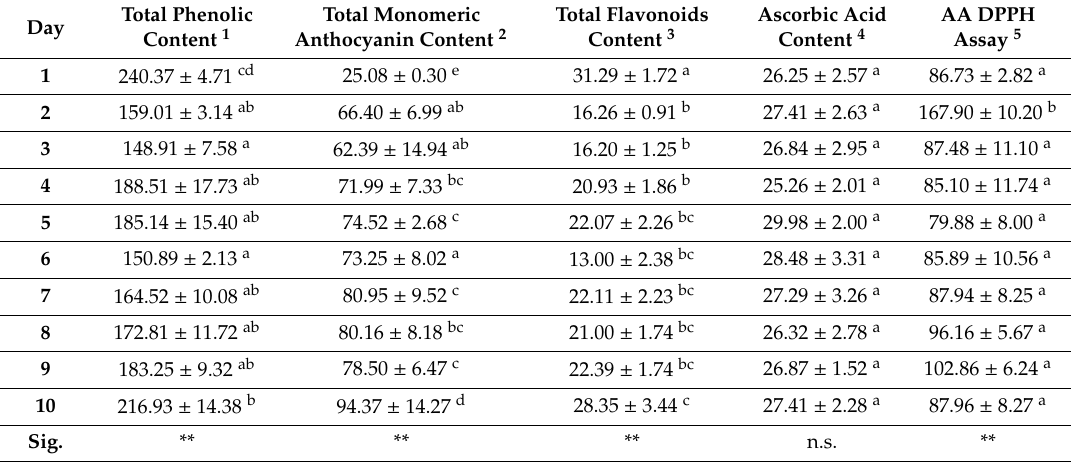
Table 5. Fruits stored at 1 ◦ C in fridge, without packaging film. E ff ect of storage period on the total phenolic content, total monomeric anthocyanin content, total flavonoid content, the ascorbic acid content, and the antioxidant activity DPPH parameters in red raspberries (cv. Erika). The results are the mean of three replicates ± Standard Deviation. ** ( P ≤ 0.01); n.s. (not significant). The letters represent the significant di ff erence vertically at P ≤ 0.05.